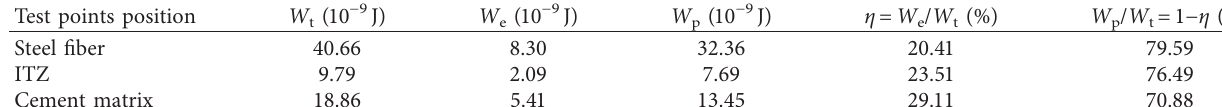
Table 3: Results of the energy indices of sample WB18SF00.